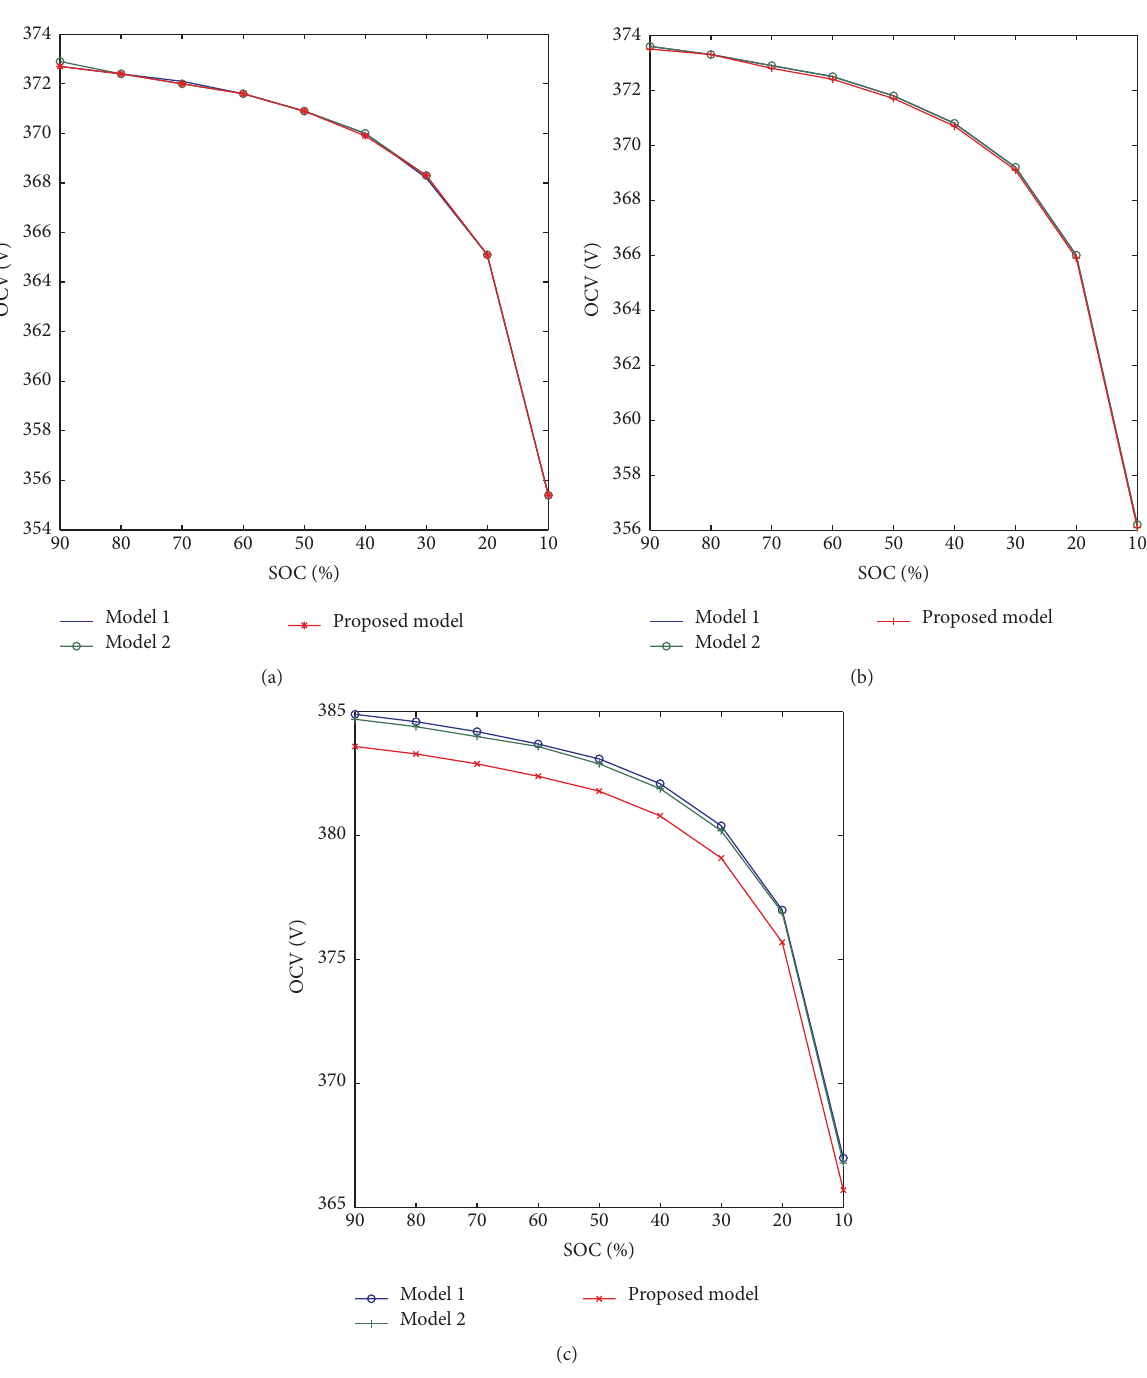
Figure 6: Temperature effect on OCV (a) at 273 K, (b) at 298 K, and (c) at 333